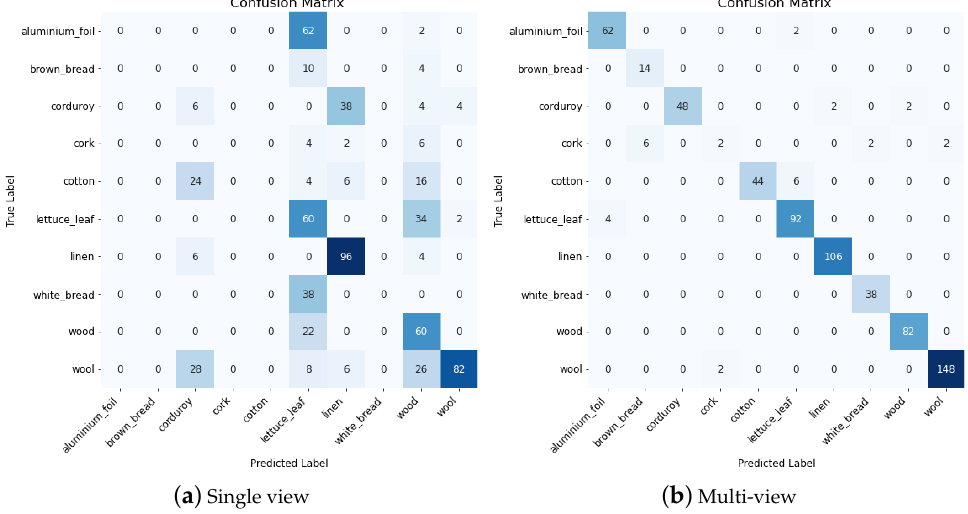
Figure 14. Confusion matrix for ( a ) Single-view model and ( b ) multiview model when using view5 and view6 from UJM TIV dataset.